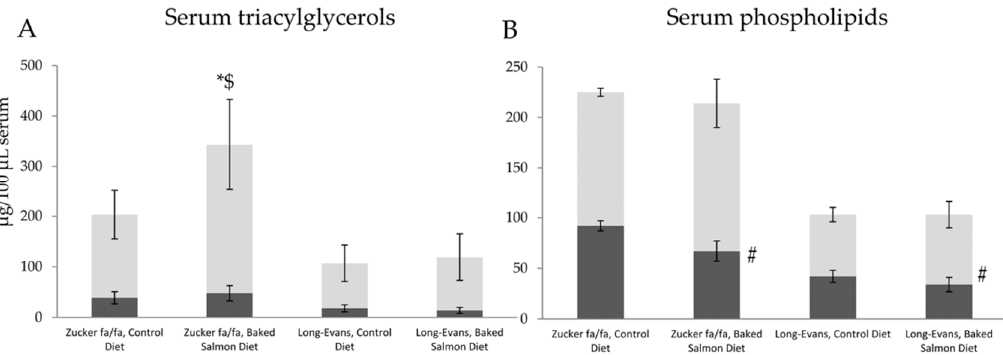
Figure 3. Fatty acids esterified as triacylglycerols ( A ) and phospholipids ( B ) in serum presenting fatty acids also found in diets (light grey bars) and fatty acids not found in diets (dark grey bars), shown as mean values with standard deviations, for n = 5 in Zucker fa/fa Control Group, and n = 6 in all other groups. p < 0.05 was considered significant. Groups within rat strains are compared using Independent Samples T Test assuming equal variances. * Total amount of fatty acids was significantly different from Control Group (same rat strain); $ amount of fatty acids found in the diet was significantly different from Control Group (same rat strain); and # amount of fatty acids not found in the diet was significantly different from Control Group (same rat strain).